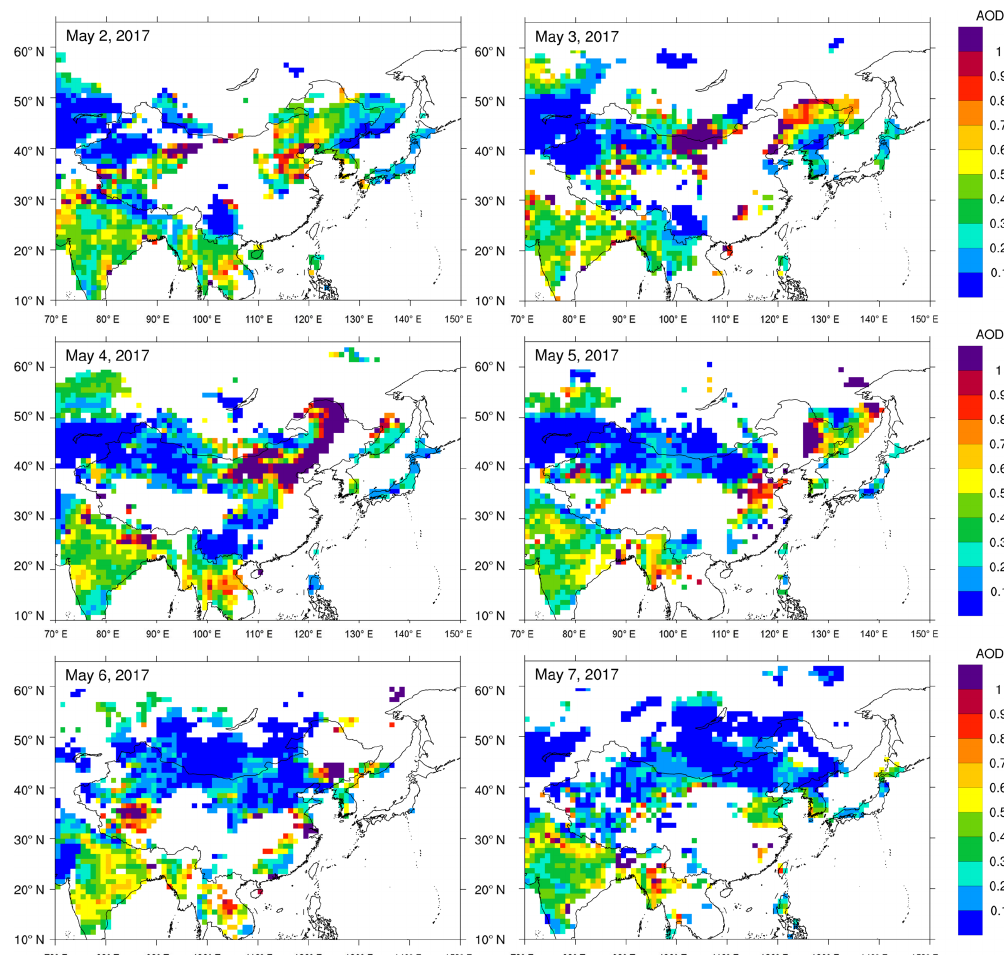
Figure 5. Distribution of mean AOD at 550nm derived from the MODIS Terra Deep Blue product in East Asia during 2–7 May